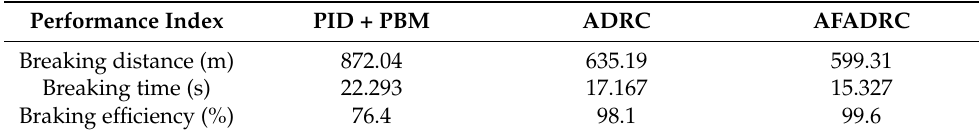
Figure 7. Case 1 simulation results: ( a ) aircraft velocity and wheel velocity; ( b ) breaking distance; ( c ) slip ratio; ( d ) AESO parameters; ( e ) control input; ( f ) extended state. Table 9. AABS performance index in Case 1.